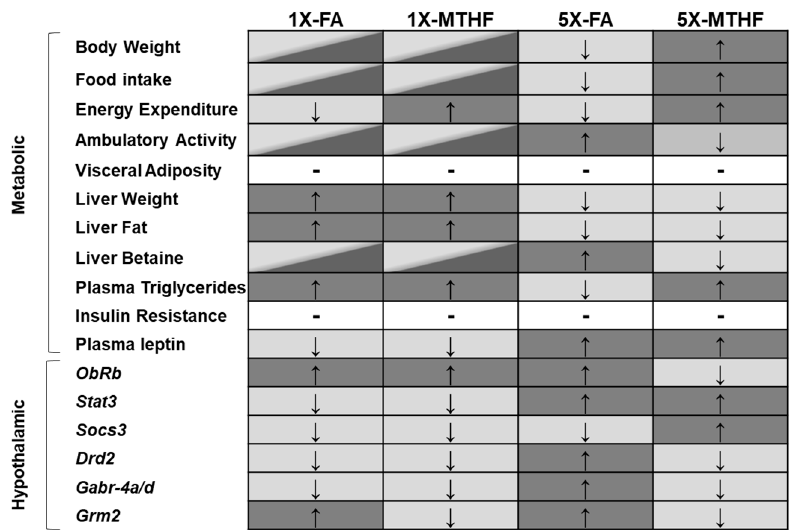
Figure 5. Summary of main metabolic and hypothalamic changes observed in offspring born to dams fed the gestational diets. Diet group panels that do not share the same colour reflect significant differences observed in the outcome measure. Panels that contain two colours have comparable outcome measures to both dark and light grey panels. Arrows indicate direction of change ( ↑ increased, ↓ decreased). Hyphen (-) indicates no difference between all groups Abbreviations: AIN-93G rodent diet with either 1X-FA, recommended folic acid (2 mg/kg diet); 5X-FA (10 mg/kg diet); 1X-MTHF, equimolar recommended [6S]-5-methyltetrahydrofolic acid calcium salt (2.1 mg/kg diet); or 5X-MTHF (10.4 mg/kg diet). ObRb, leptin receptor long isoform; Stat3, signal transducer and activator of transcription 3; Socs3, suppressor of cytokine signaling-3; Drd2, dopamine receptor type 2; Gabr-4a/d, gamma-aminobutyric acid type A receptors subunit 4alpha and delta; Grm2, gluta-